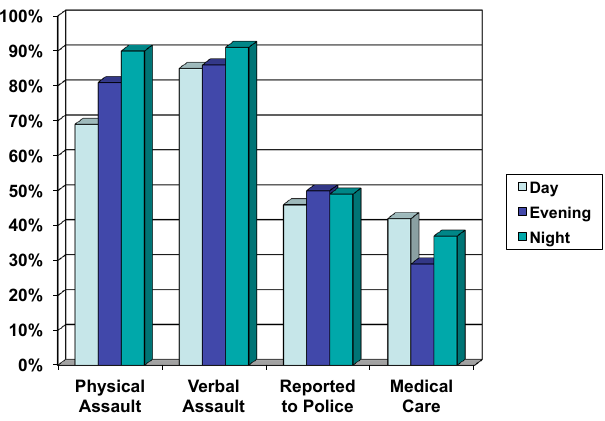
Figure 2. Percentage of assaults and safety behaviors by shift